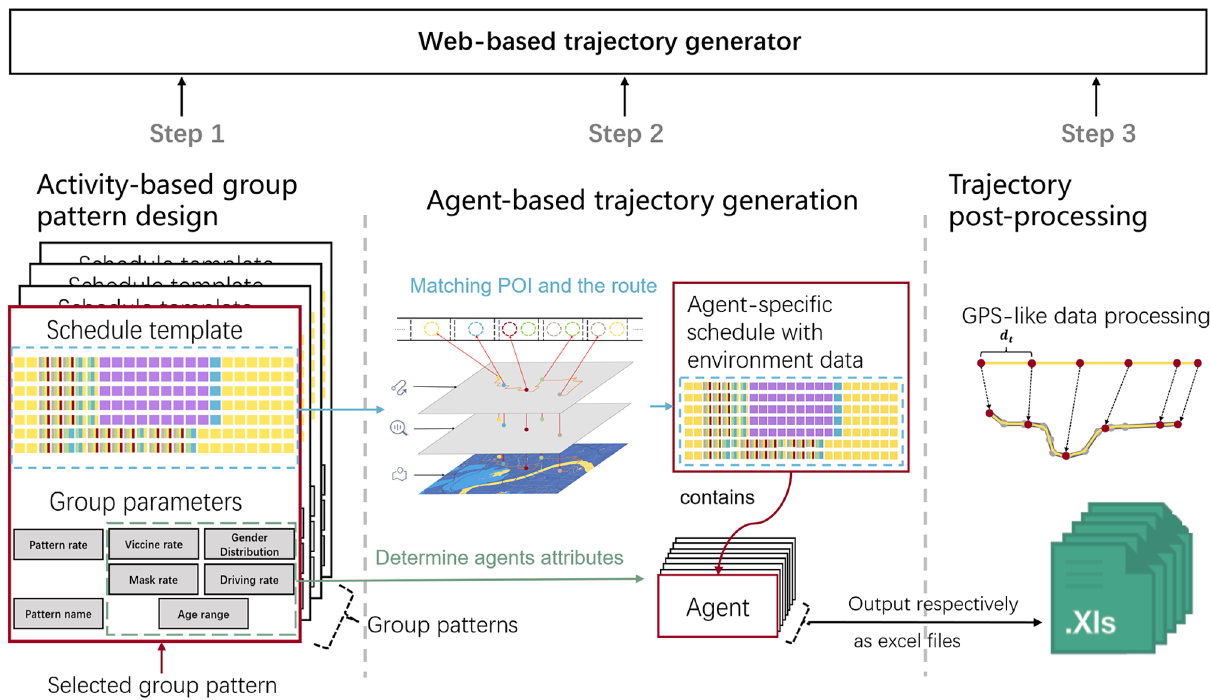
Figure 1. Overview of the proposed methods. Three steps are used to describe our proposed